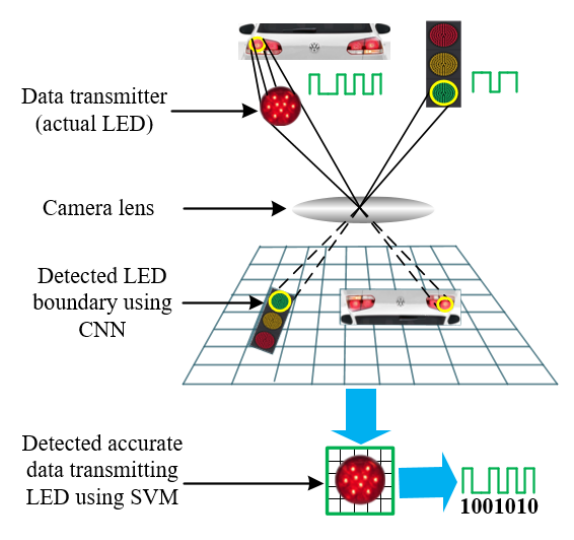
Figure 1. Scenario of the intelligent receiving system for